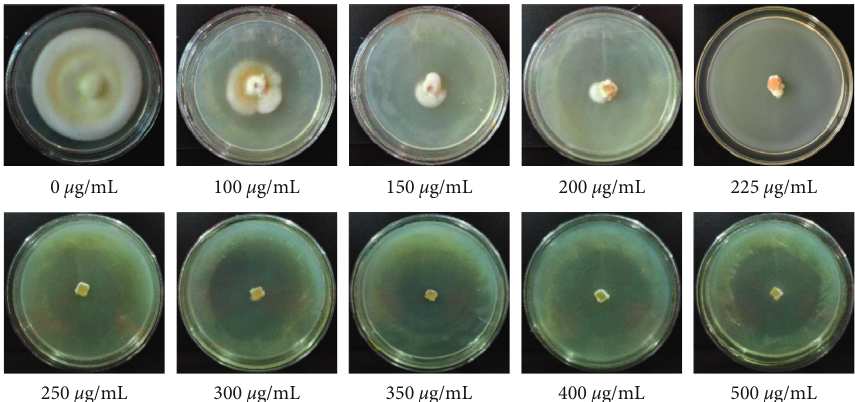
Figure 2: Inhibition of different concentrations of glufosinate ammonium on the growth of C. militaris . (a) 0 μ g/mL. (b) 100 μ g/mL. (c) 150 μ g/mL. (d) 200 μ g/mL. (e) 225 μ g/mL. (f) 250 μ g/mL. (g) 300 μ g/mL. (h) 350 μ g/mL. (i) 400 μ g/mL. (j) 500 μ g/mL.